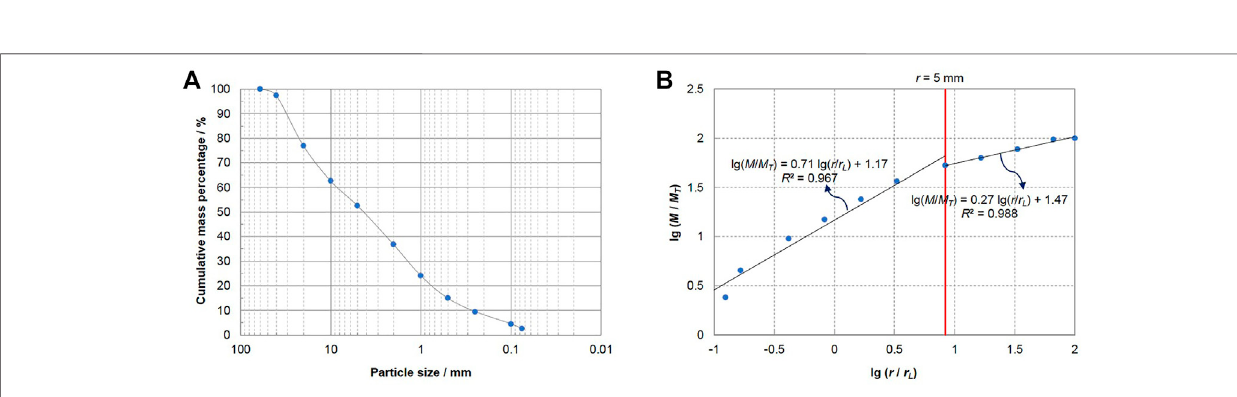
Frontiers in Earth Science |